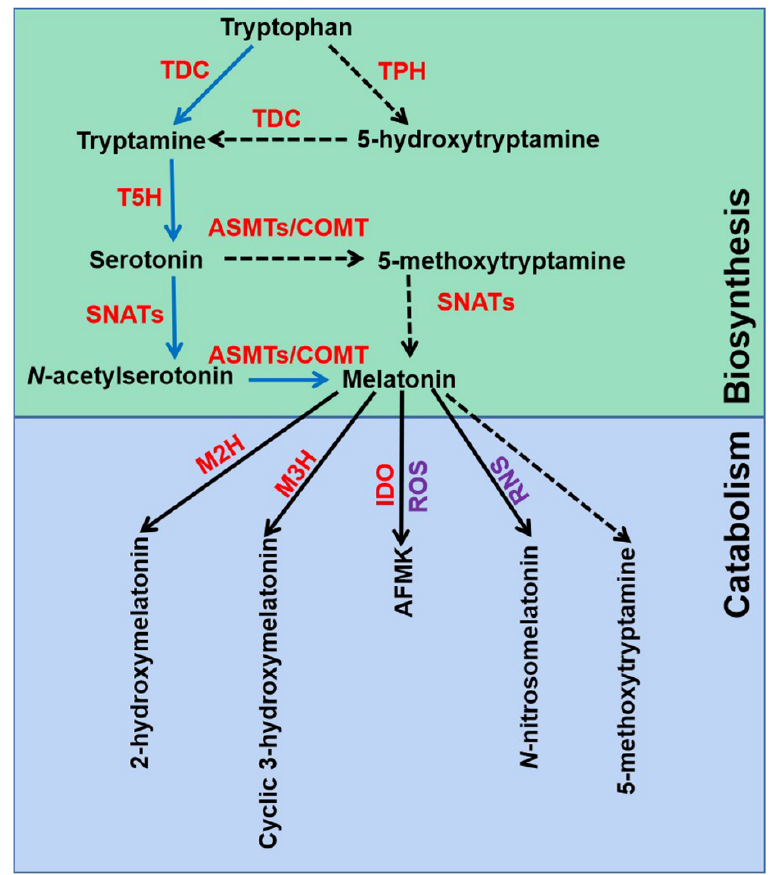
Figure 1. Melatonin biosynthesis and metabolic pathways in plants. TDC, tryptophan decarboxylase; T5H, tryptamine 5-hydroxylase; TPH, tryptophan hydroxylase; SNATs, serotonin N-acetyltransferases; ASMTs, N-acetylserotonin-O-methyltransferases; COMT, caffeic acid O-methyltransferase; M2H, melatonin 2-hydroxylase; M3H, melatonin 3-hydroxylase; IDO, indoleamine 2,3-dioxygenase; AFMK, N 1 -acetyl- N 2 -formyl-5-methoxykynuramine; ROS, reactive oxygen species; RNS, reactive nitrogen species. The green box indicates melatonin biosynthesis pathways, and blue box indicates melatonin metabolic pathways.